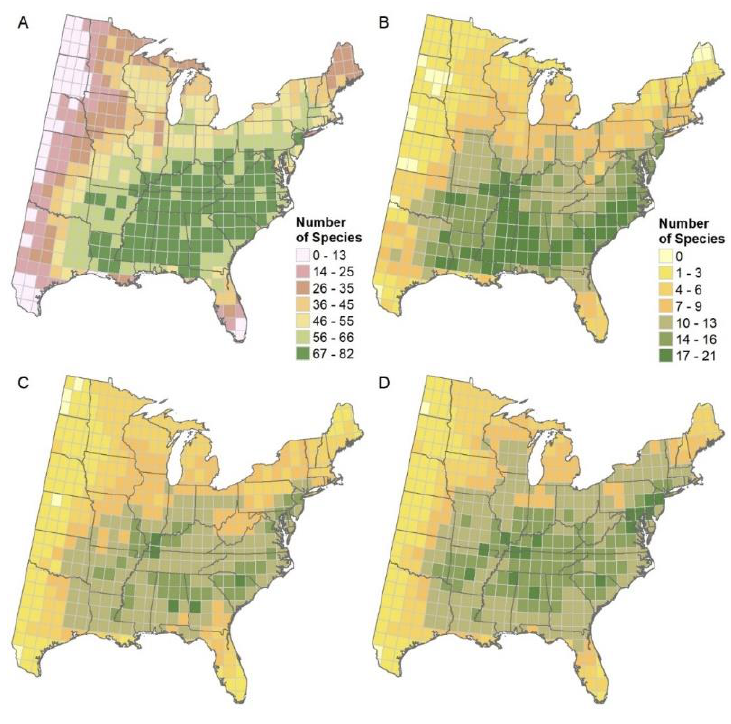
Figure 6. ( A ) The number of species recorded by FIA by 1 × 1 degree cell across the eastern US. ( B ) The number of oak ( Quercus spp.) species recorded by FIA by 1 × 1 degree cell across the eastern US. ( C ) The number of oak ( Quercus spp.) species projected to have suitable habitat (HQ) and at least some chance of colonization (CL) at 2100 according to RCP 4.5. ( D ) The number of oak ( Quercus spp.) species projected to have suitable habitat (HQ) and at least some chance of colonization (CL) at 2100 according to RCP 8.5. Figures ( C , D ) use same figure legend as ( B) .